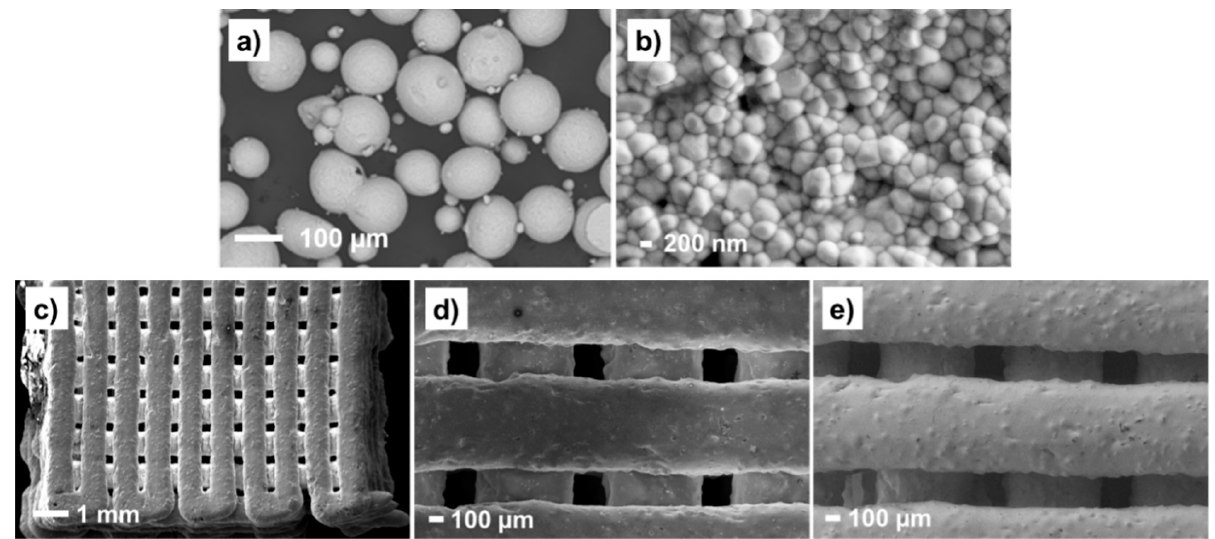
Figure 3. SEM micrographs of ( a ) 3Y-TZP powder; ( b ) zirconia paste after robocasting and sintering; ( c ) 3D-printed zirconia filaments and macropores created by the robocasting architecture; ( d , e ) high magnification micrographs with a detail of 3 well-arranged filaments. All images were taken with an InLens detector, with the exception of Figure ( e ) where the secondary electrons detector (SE) was employed to better visualize the surface texture of the filaments.